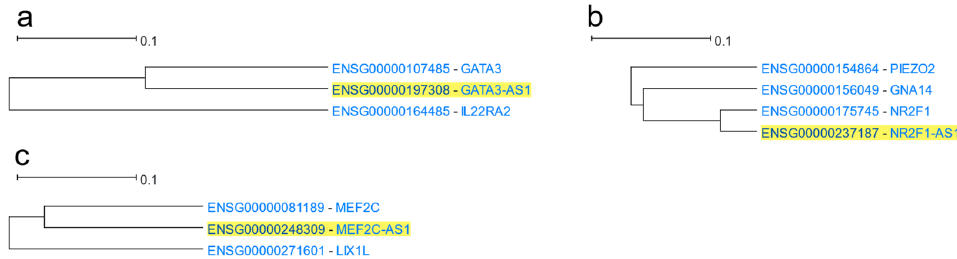
Figure 15. HGCA2.0 coexpression clades of sense genes and their respective antisenses; ( a ) HGCA2.0 GATA3 2 internal node coexpression clade; ( b ) HGCA2.0 NR2F1 3 internal node coexpression clade; ( c ) HGCA2.0 MEF2C 2 internal node coexpression clade.